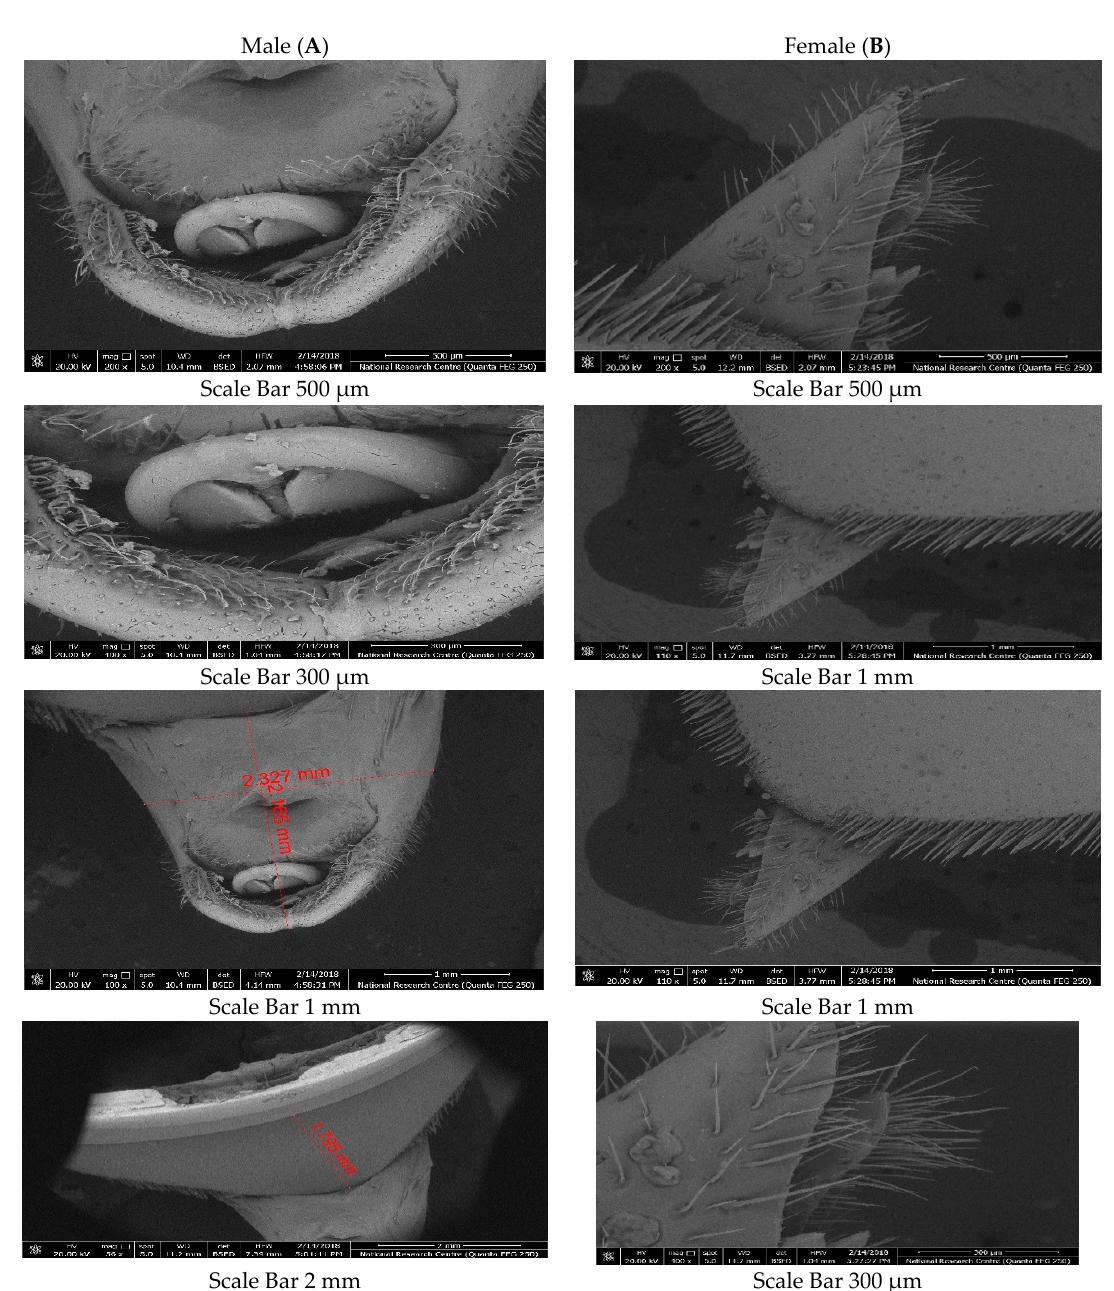
Figure 6. SEM of pygidium of R. ferrugineus male ( A ) and female ( B ) adult RPW, showing the sexual dimorphism between both sexes and high variability (note: p > 0.05, n = 13 random individuals/sex) between adults brought during 2019, (scale bar below each picture and measurements are shown on the picture).